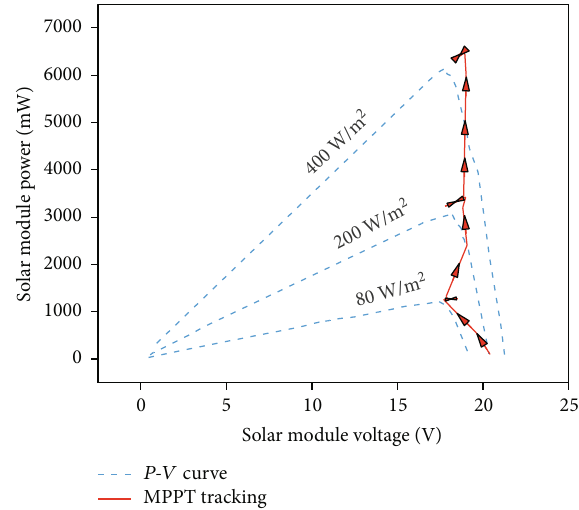
Figure 14: Designed MPPT tracking result.